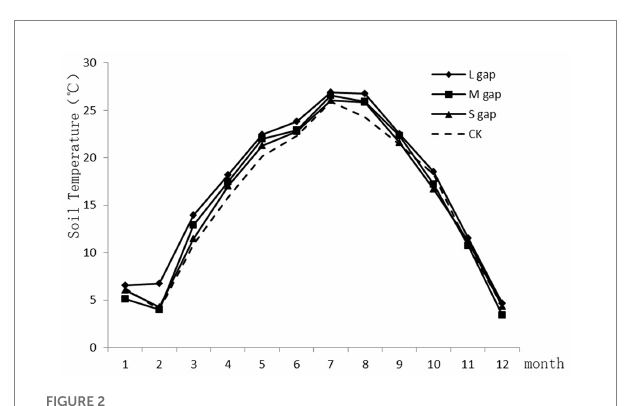
FIGURE 2 Monthly mean soil temperature in different sizes of gaps in Platycladus orientalis